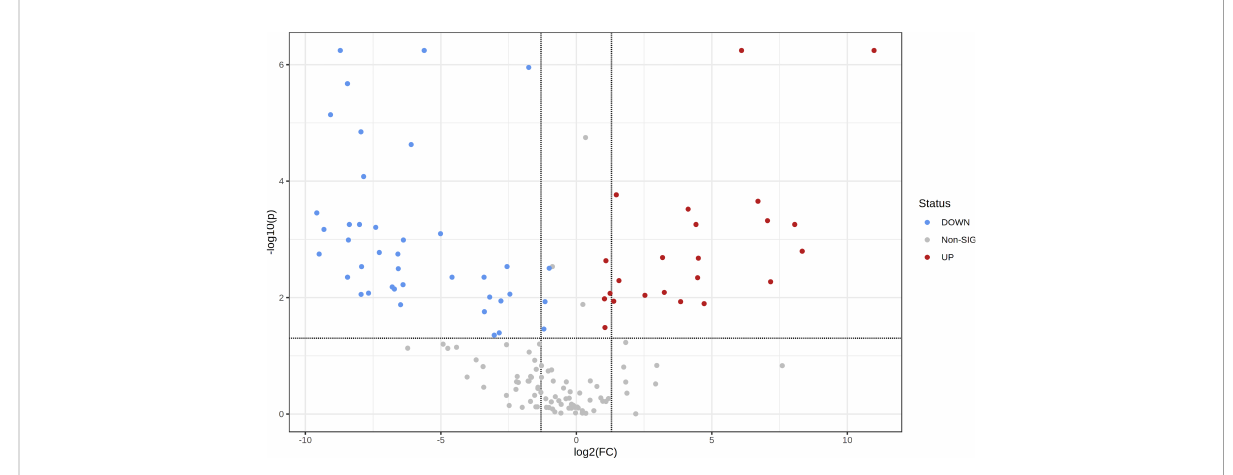
FIGURE 4 Volcano plot showing the metabolic features ’ relative content in fresh leaf extracts (FLE) and dried leaf extracts (DLE). Higher content in FLE is given by FC < 2 and p < 0.05; higher content in DLE is given by FC > 2 and p <